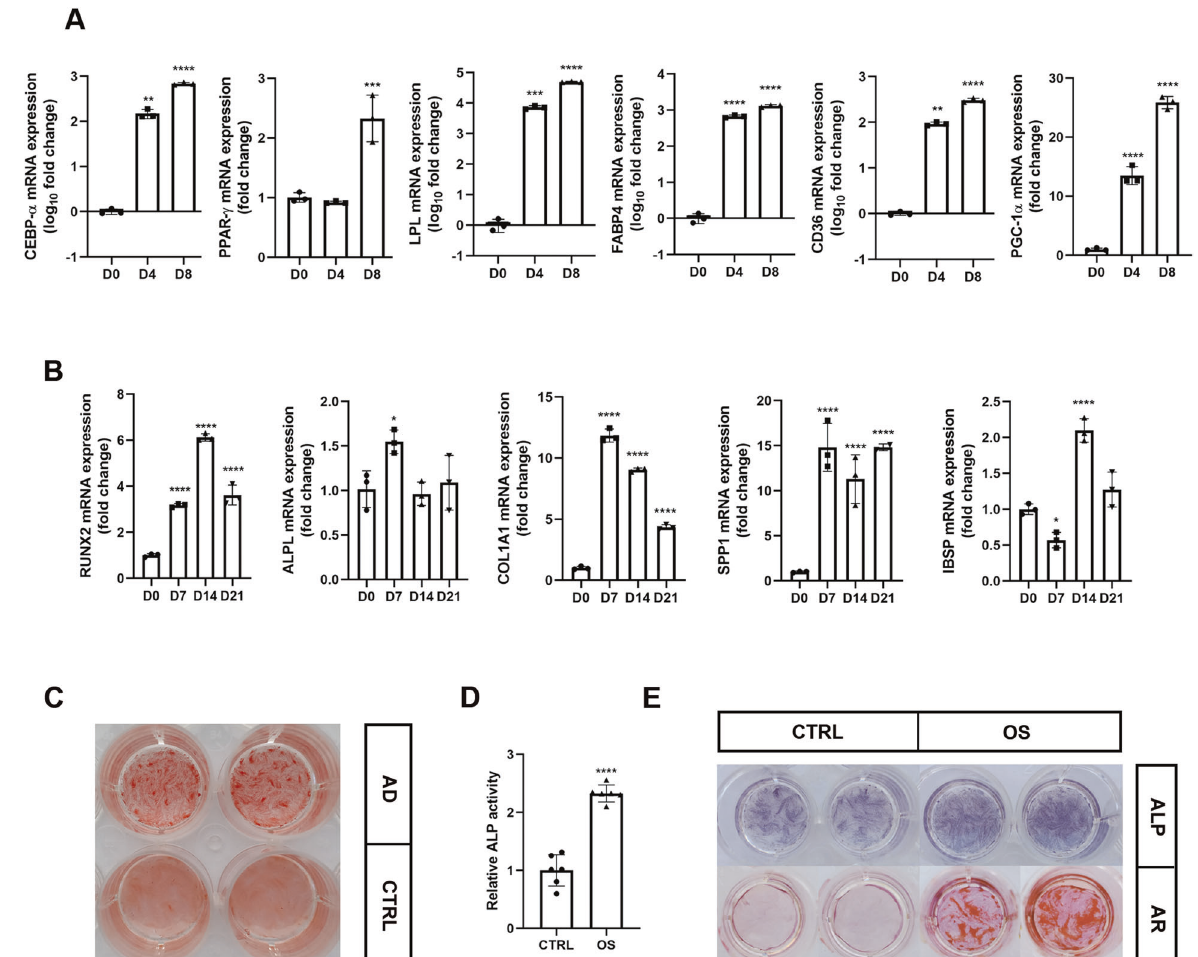
Fig. 1 The differentiation ability of hMSCs. A mRNA levels of CEBP- α , PPAR- γ , LPL , FABP4 , CD36 and PGC-1 α during hMSCs adipogenic differentiation at D0, D4 and D8 ( n = 3). B mRNA levels of RUNX2 , ALPL , COL1A , SPP1 and IBSP during hMSCs osteogenic differentiation at D0, D7, D14 and D21 ( n = 3). C Oil red O staining was performed at D16 after adipogenic induction. D , E ALP activity assay ( n = 6) and ALP staining were performed at D7 ( D , E ), alizarin red staining was performed at D21 after osteo genic induction ( E ). Results are shown as mean ± SD. * indicates a signi fi cant difference from the control group, * p < 0.05, ** p < 0.01, *** p < 0.001, **** p <